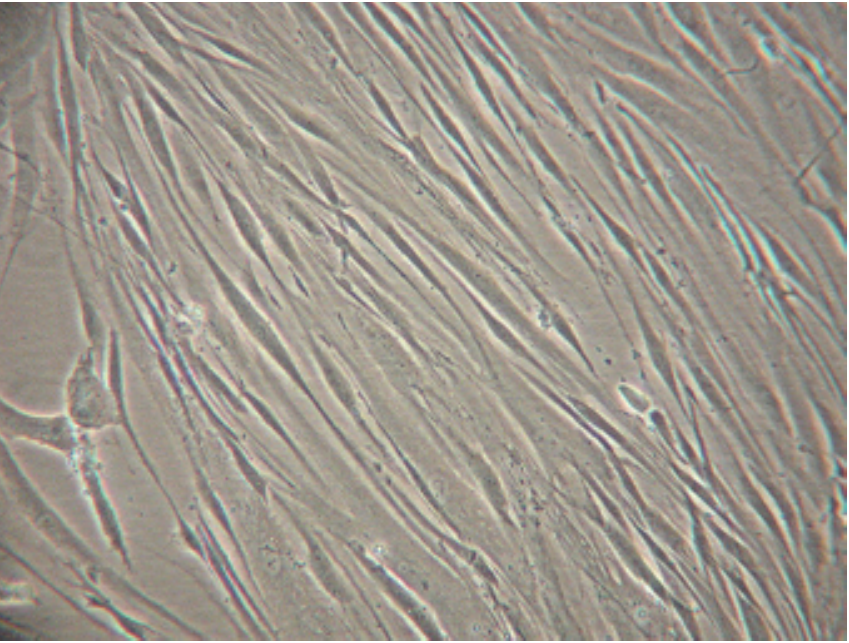
FIGURE 2 - Human fibroblasts in Petri dish with fusiform morphology.